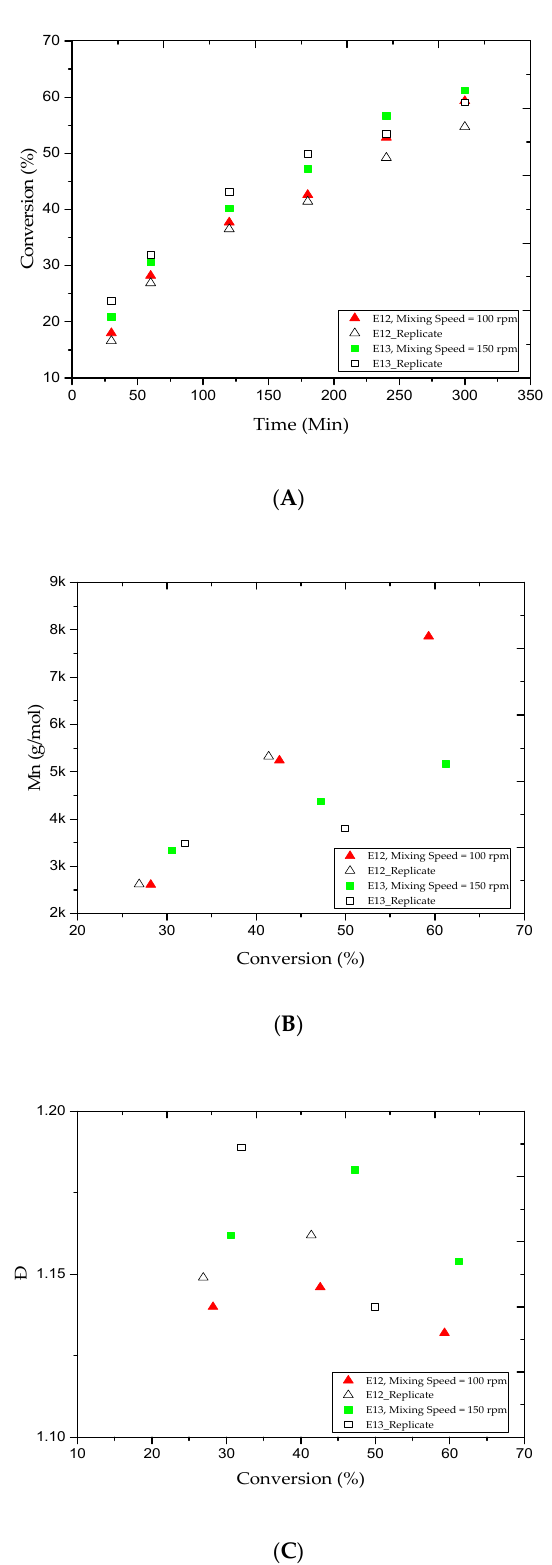
Figure 4. For experiments E12 and E13: ( A ) methyl methacrylate (MMA) conversion rate versus reaction time; ( B ) variations in the experimental number-average molar mass (M n ) versus the methyl methacrylate (MMA) conversion rates; and ( C ) variations in the polydispersity index (Ð) versus the methyl methacrylate (MMA) conversion